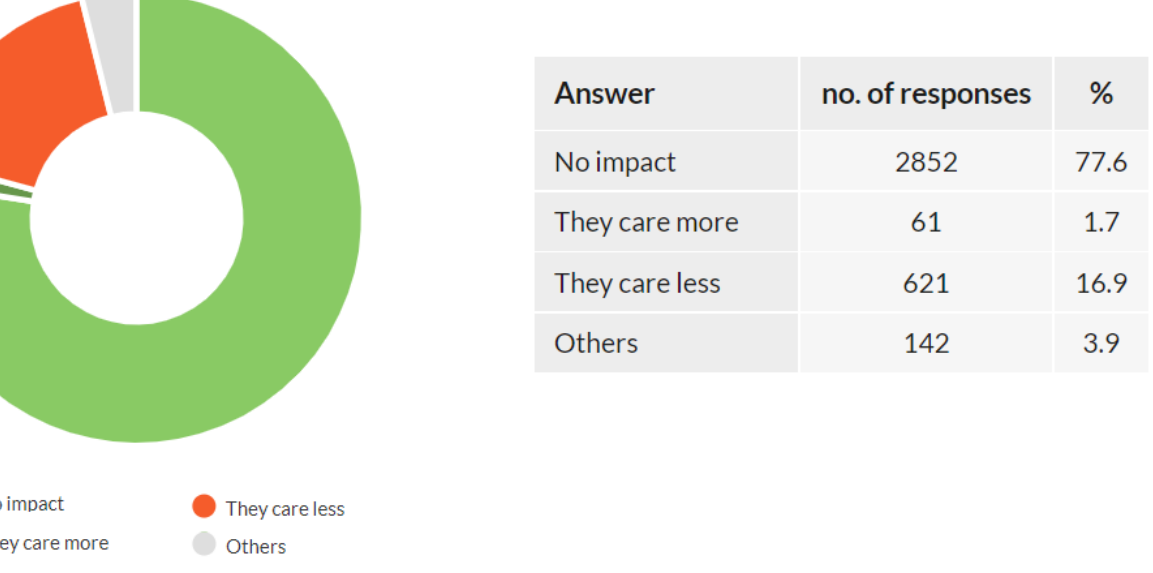
Figure 7. Impact of the pandemic on the oral care of Czech patients.